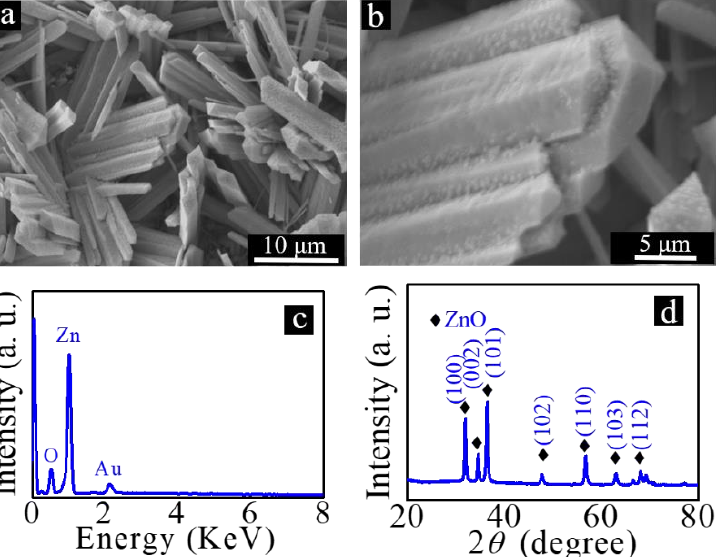
Figure 4. ( a ) Low- and ( b ) high-magnification SEM images of rod-like ZnO with ZnO seed layer loaded on its surface; ( c ) EDX spectrum and ( d ) XRD diffraction patterns of rod-like ZnO.